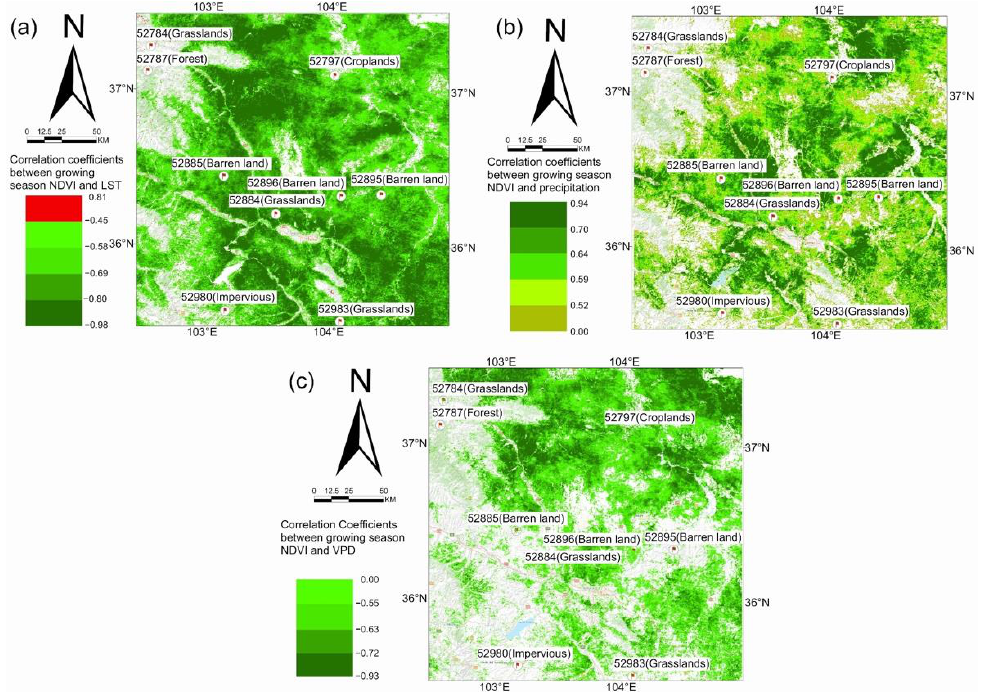
Figure 8. Correlation coefficients between the growing season vegetation greenness and the three climatic factors: ( a ) land surface temperature, ( b ) precipitation, ( c ) atmospheric vapor pressure deficit. The correlation coefficients are at the interannual scale for the years from 2000 to 2019.